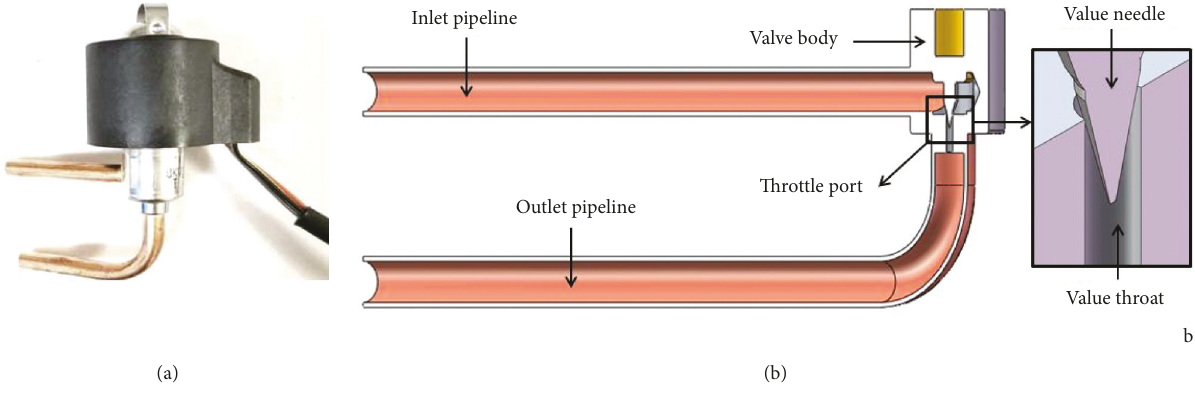
Figure 1: The EEV: (a) photo of the actual product and (b) section view of the